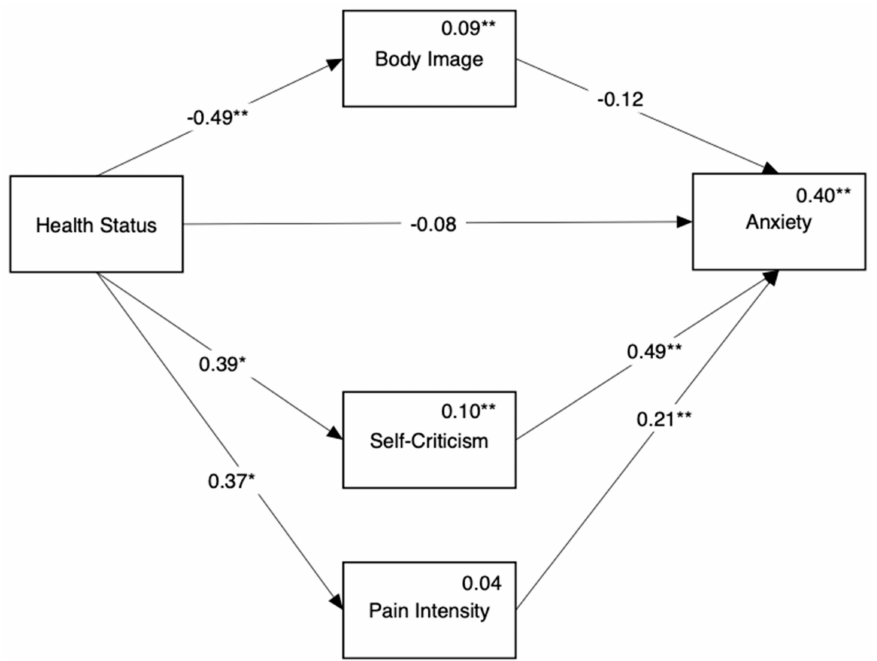
Figure 5. Mediation of the link between disease-status (endometriosis only or endometriosis ACI) and anxiety, by body image, self-criticism, and pain intensity. Reference group for comparison is the Endometriosis only group. Numbers above the direct links are standardized regression coefficients. Numbers above variable names are multiple squared correlations. Age was included in the model as a covariate, yet is not presented in this figure. * p < 0.05, ** p <